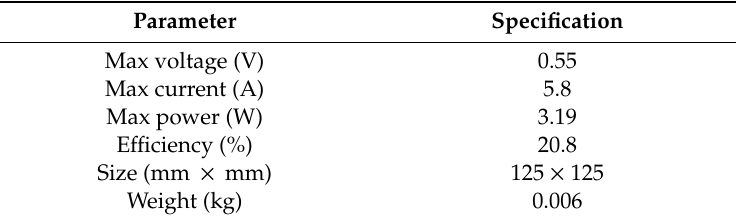
Figure 5. Overview of the PV ( a ) cell and ( b ) module. Table 2. Specifications of the photovoltaic (PV)